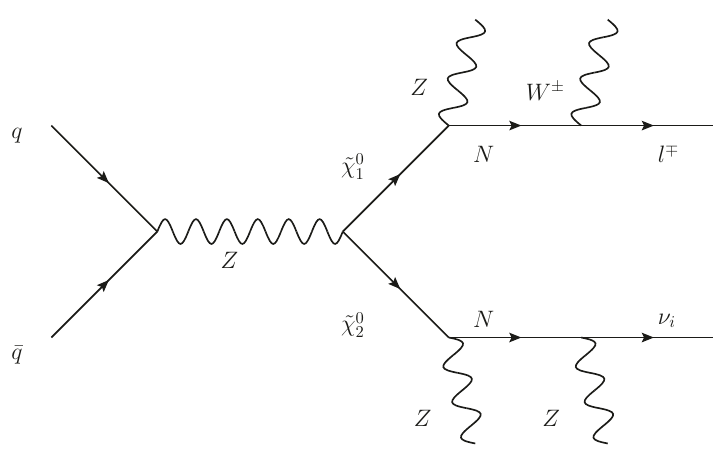
Figure 1 . Production and decay of the pseudo-Goldstone sterile neutrino in the “on-shell” case ( m N > m Z ). In this example, two sterile neutrinos are produced in the decay of a ˜ χ 0 ( pp → ˜ χ 0 ˜ χ 0 → ZZNN ), before decaying to W ± l ∓ and Zν i , 1 2